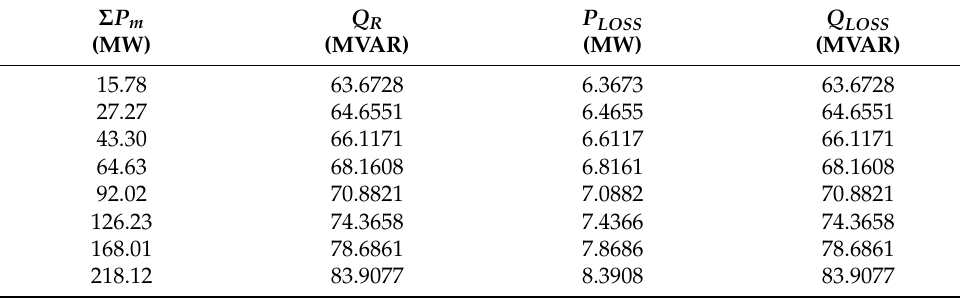
Table 8. DFIG reactive power and losses (PF = 1.0).